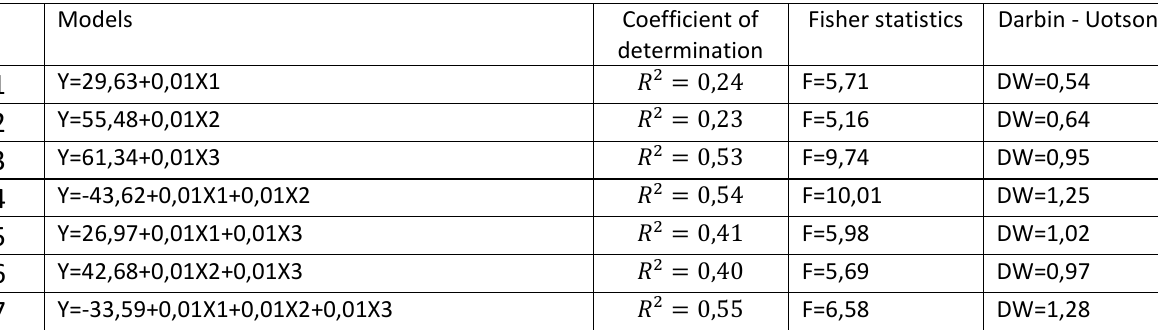
Table 2. Regression models of existing dependencies in the system of small and medium enterprises Models Coefficient of